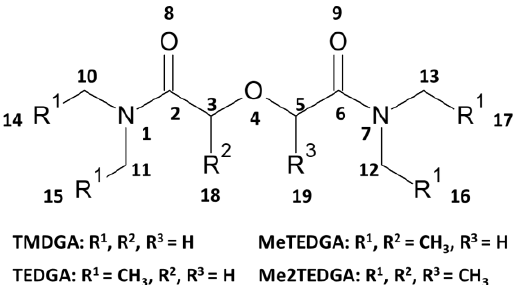
Figure 1. The structural formula of the investigated DGAs molecules.